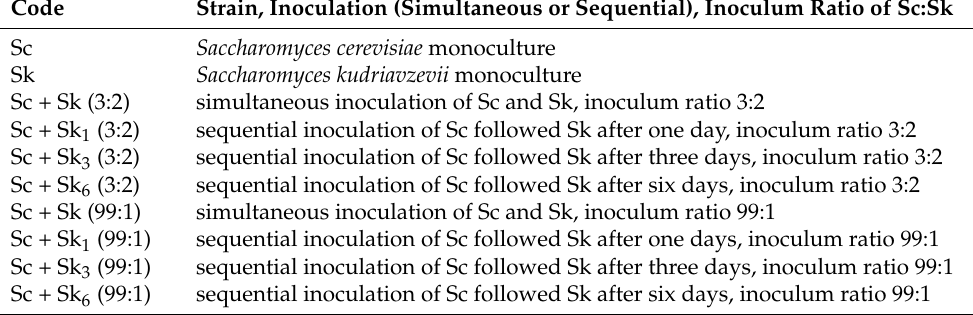
Table 5. Mixed fermentation